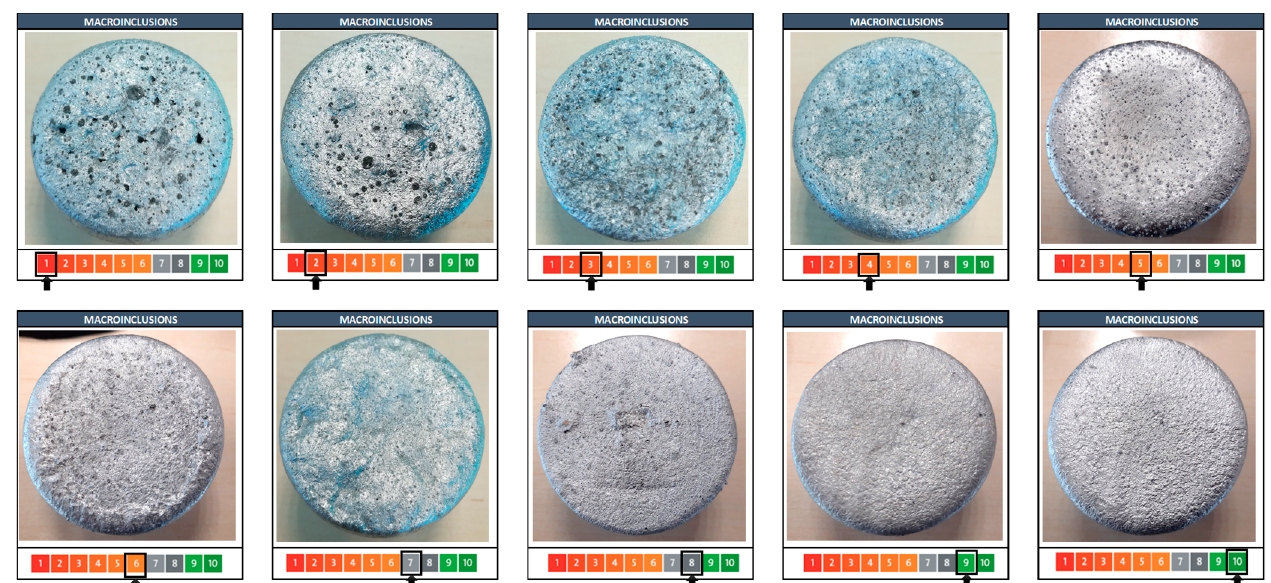
Figure 3. Macroinclusion level chart for the determination of the inclusion rating level in the melt (macroinclusion analysis). Microinclusion level: The melt was cast into a crucible of about 2 kg capacity and the